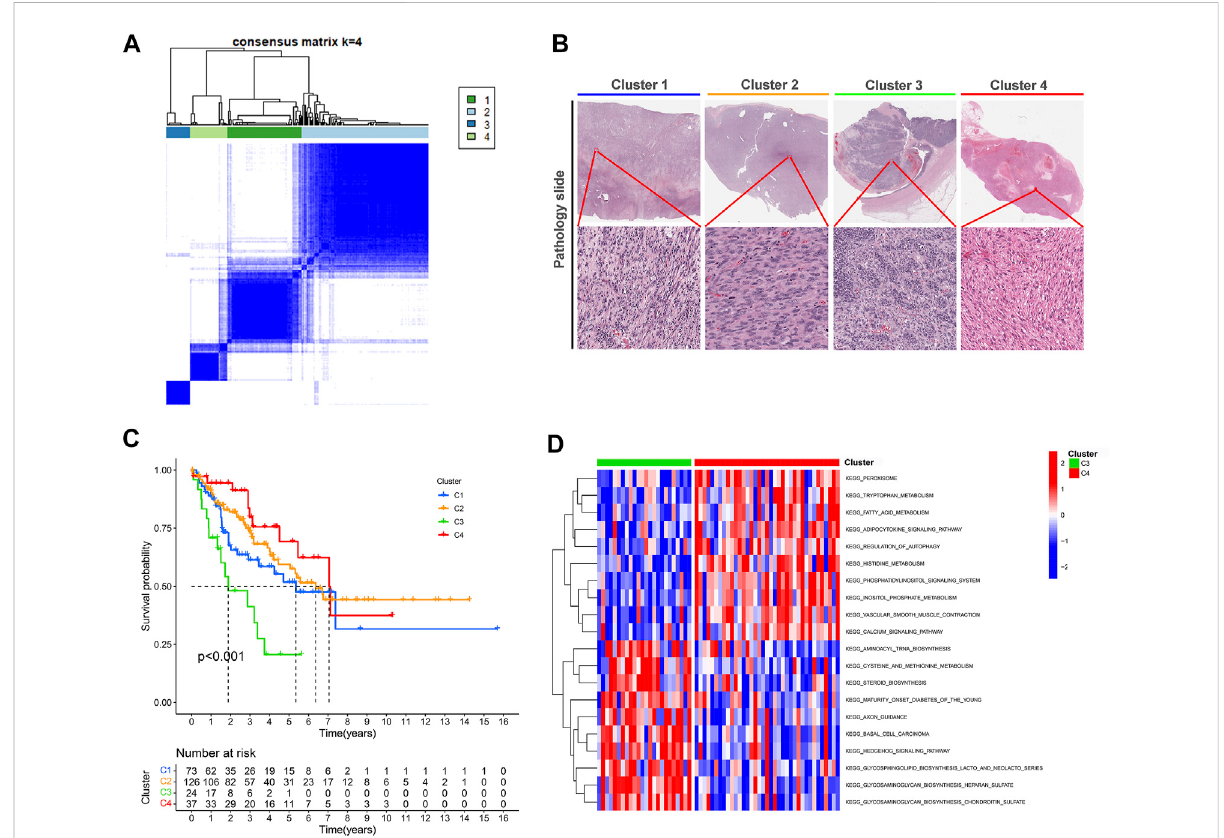
FIGURE 5 Unsupervised learning for cuproptosis lncRNA classi fi cation. (A) Unsupervised clustering of six cuproptosis lncRNAs and the optimized consensus matrix with k = 4. (B) Representative images of the pathological HE staining of the four clusters in TCGA-SARC. (C) Kaplan-Meier Curves for differential survival of four cuproptosis lncRNA clusters in the TCGA-SARC. (D) The KEGG enrichment levels comparison between cluster 3 and cluster